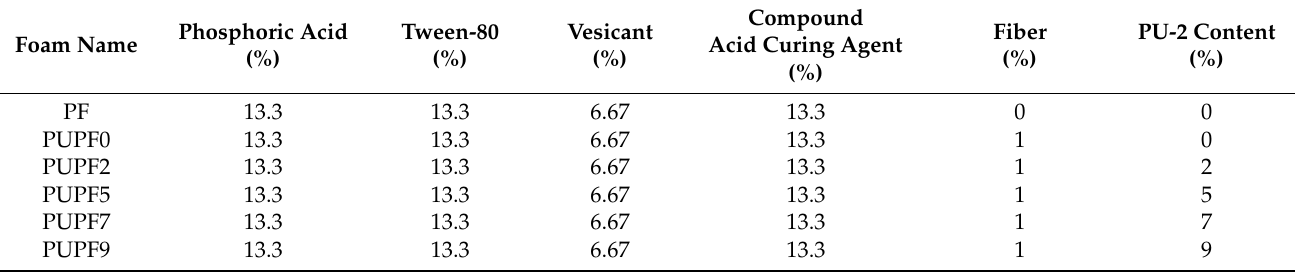
Table 2. Formulation of foam